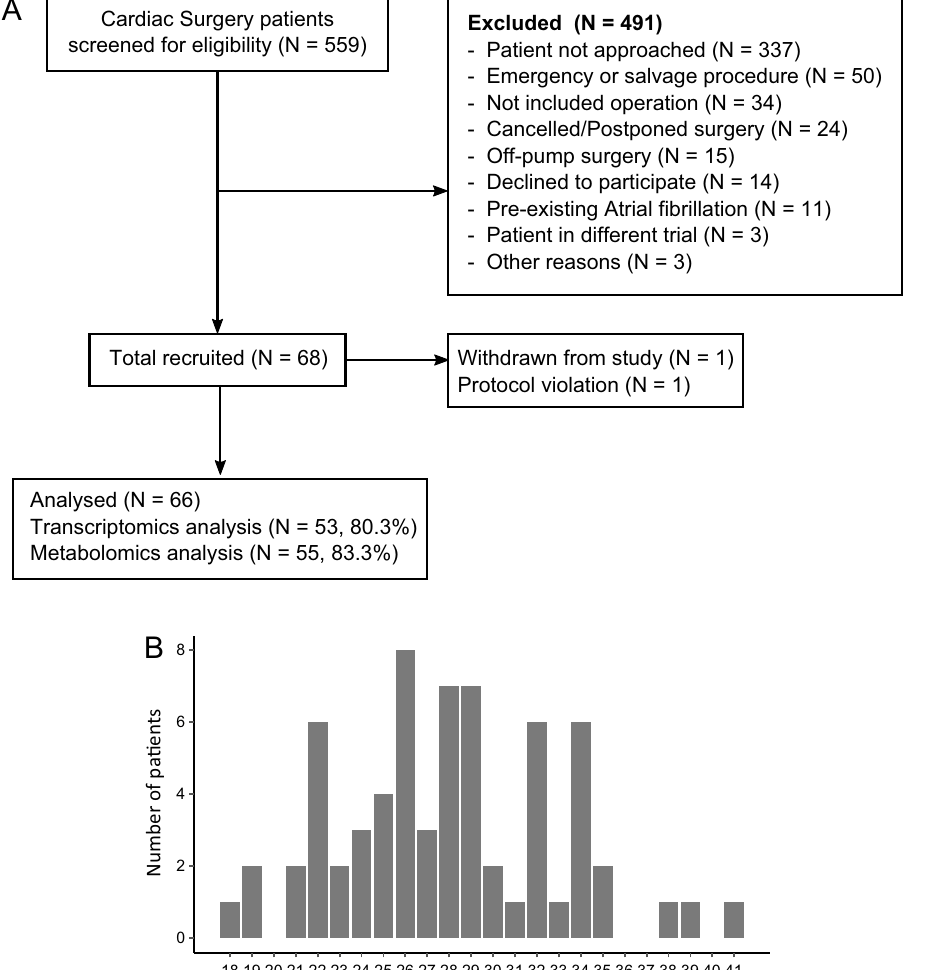
Figure 1. ( A ) Consort diagram, ( B ) BMI distribution in the